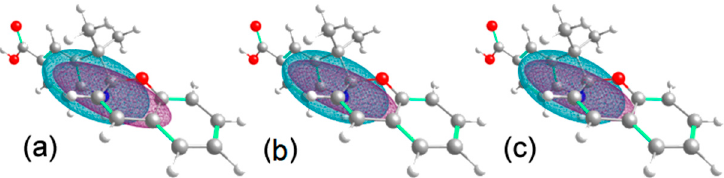
Figure 10. Depletion (blue) and increment (purple) regions for spiropyran 7 in dichloromethane ( a ), acetonitrile ( b ) and methanol ( c ) for the S 0 → S 1 transition.